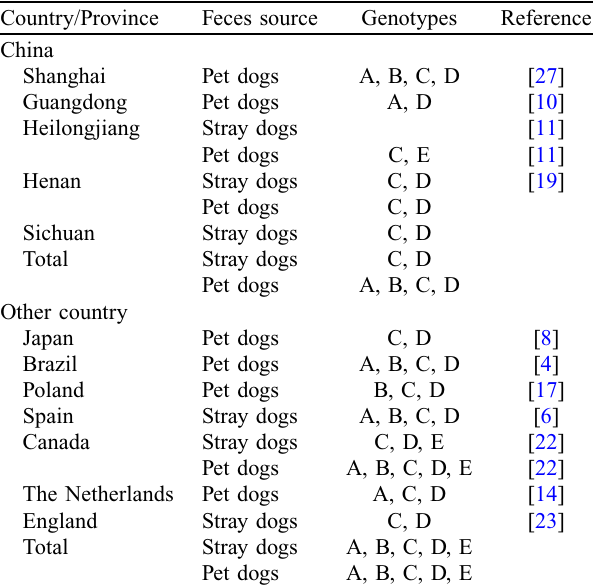
Table 4. Prevalence of Giardia duodenalis in different sample sources in China and other countries by amplification of the bg